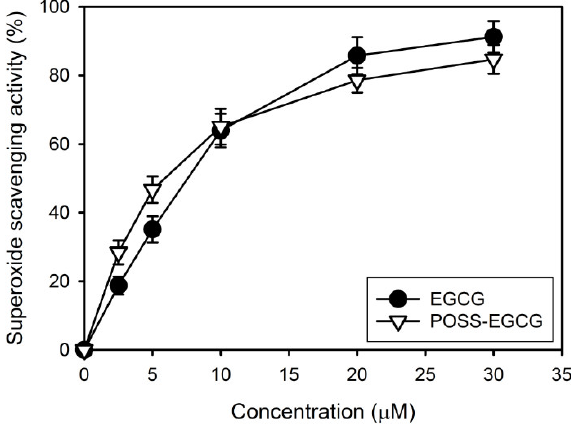
Figure 8. Superoxide anion scavenging activities of EGCG and the POSS–EGCG conjugate ( n = 4).